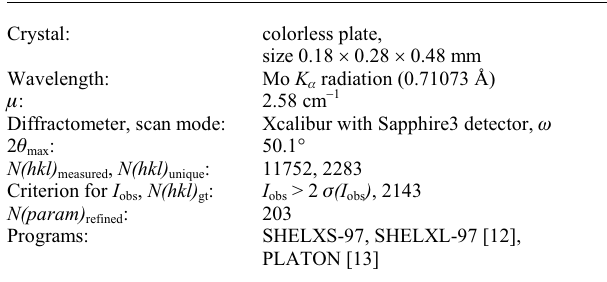
Table 1. Data collection and